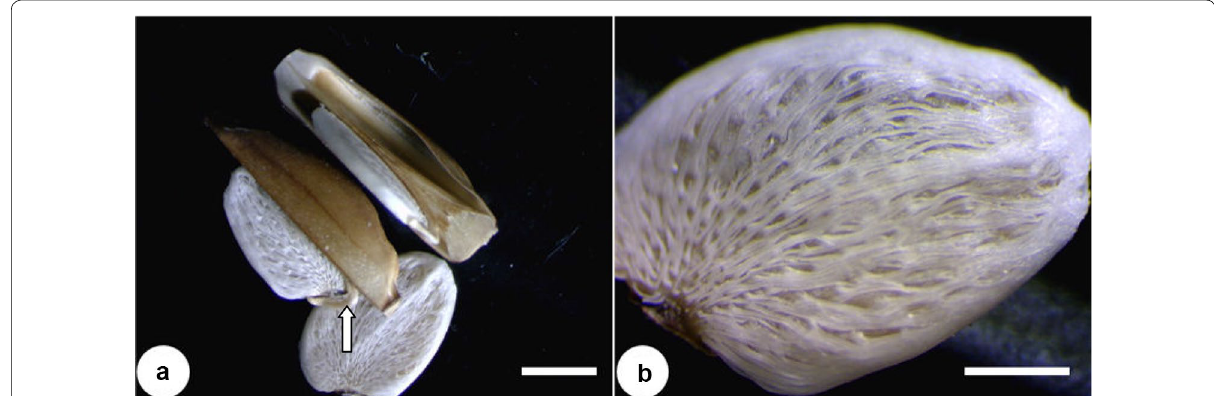
Fig. 5 Dry, mature bilocular capsules from a Blepharis plant with a pair of seeds on retinacula (arrowhead). a Capsule with seeds. b Close‑up of a flat and ovate seed coated with hygroscopic hairs. Scale bars